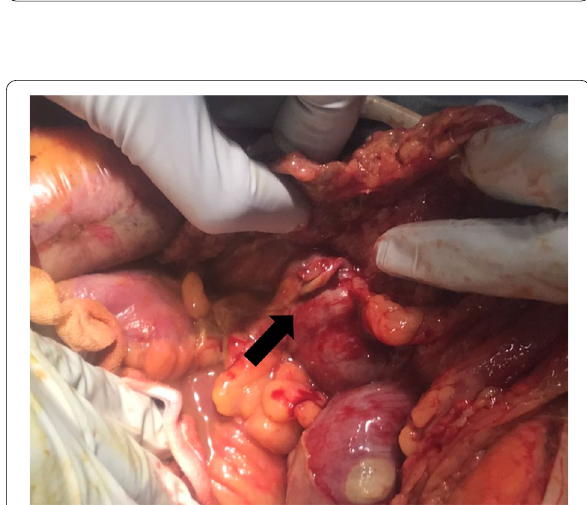
Fig. 3 During an operation, perforation sites were identified at the right side of the transverse colon (arrow) and the tissue around the perforation sites was necrotic